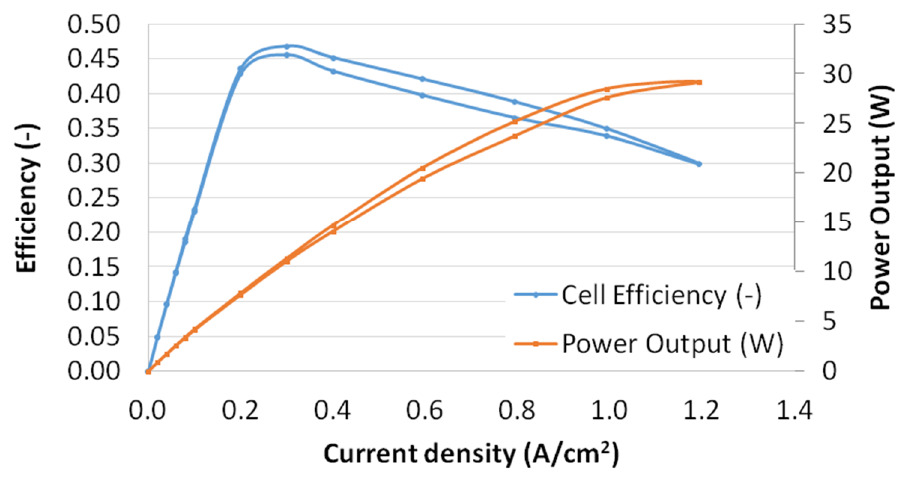
Figure 11. Cell efficiency curve and power curve for reference conditions (Table 1); λ a = 1.3. Figure 11. Cell e ffi ciency curve and power curve for reference conditions (Table 1); λ a =